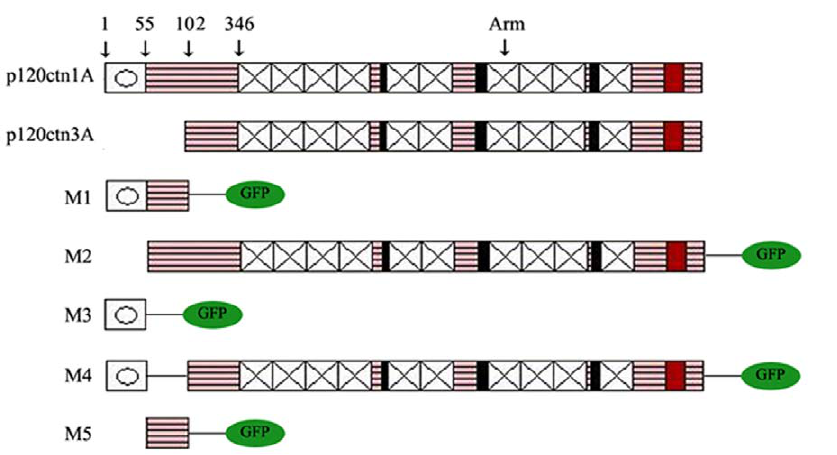
Figure 1. P120ctn isoform 1A, isoform 3A and five p120ctn 1A deletion mutants M1 to M5. P120 isoform 1A contains the coiled-coil domain and a central armadillo domain. P120 isoform 3A lacks the coiled-coil domain. Five p120ctn 1A deletion mutants M1 to M5 fused to green fluorescent protein (GFP): M1 contains only N-terminal 1–101 amino acids; M2 has N-terminal 1–54 amino acids deleted; M3 contains only N-terminal 1–54 amino acids; M4 has N-terminal 55–101 amino acids deleted; M5 contains only N-terminal 55–101 amino